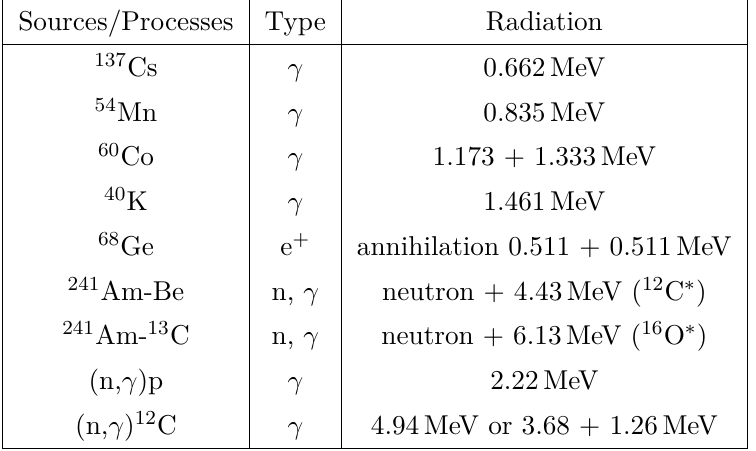
Table 1 . List of radioactive sources and processes considered in JUNO calibration.